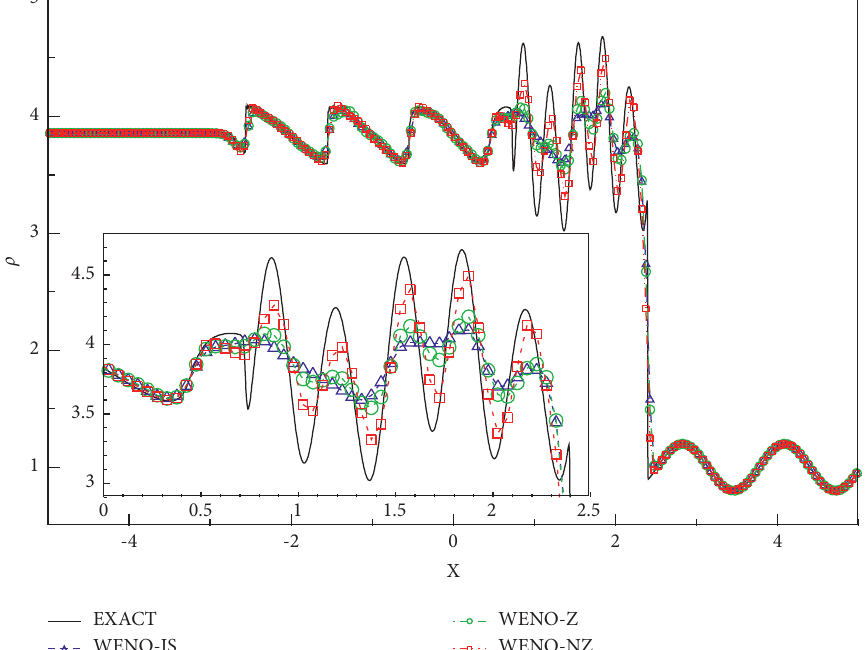
Figure 4: Numerical solutions of shock entropy wave interaction at t � 1 . 8 computed by WENO-JS, WENO-Z, and WENO-NZ schemes with grids of N � 200.